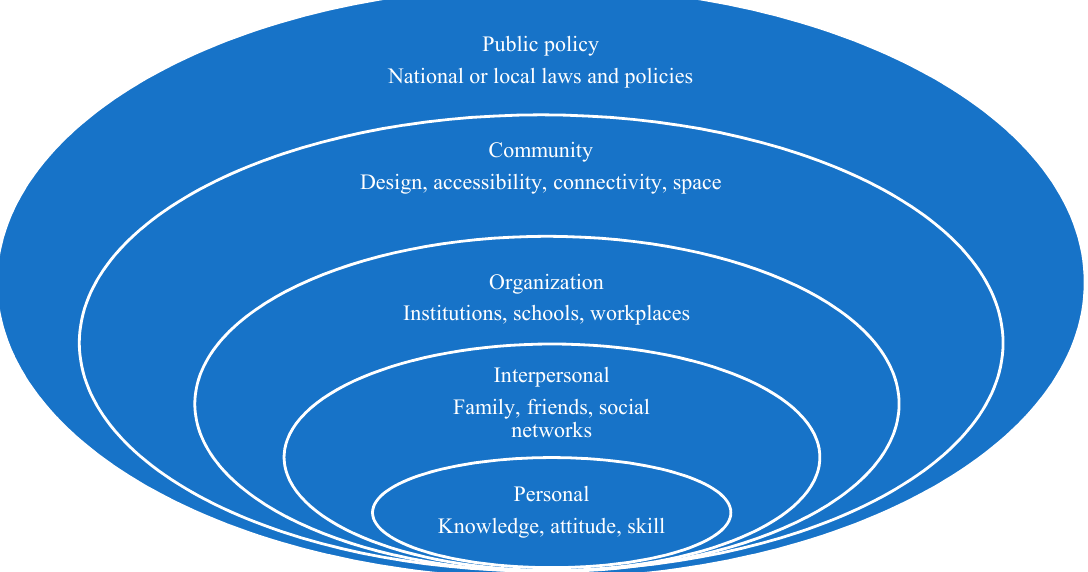
Figure 1. The social ecological model adapted from McLeroy, K.R., Bibeau, D., Steckler, A., and Glanz, K. (1988) [16]. An ecological perspective on health promotion programs.